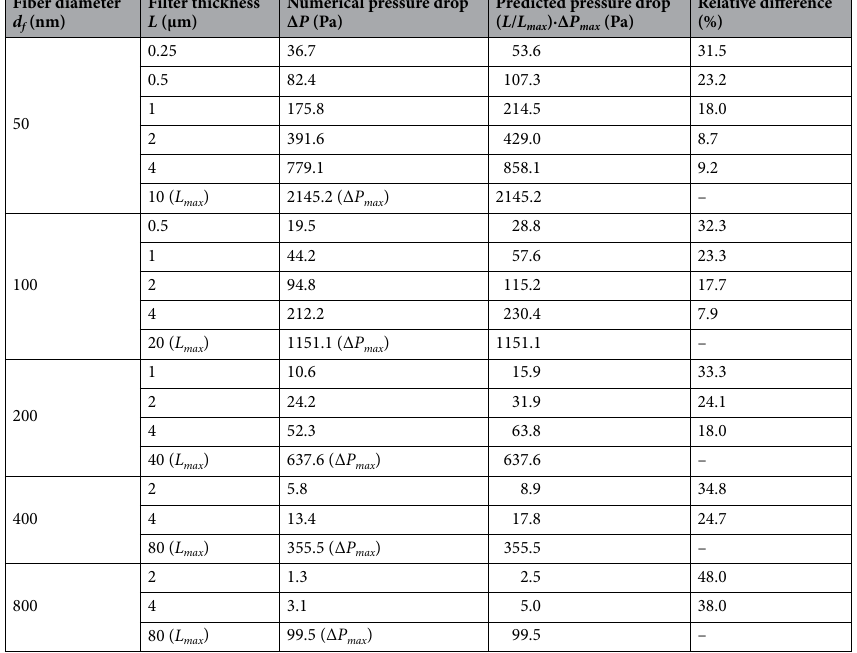
Table 2. Filter thickness and pressure drop values for the different cases plotted in Fig.